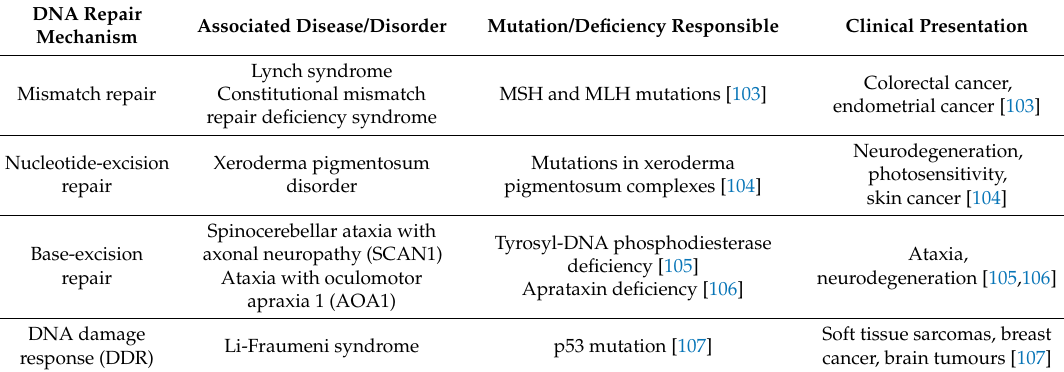
Table 1. Diseases and disorders associated with defective DNA